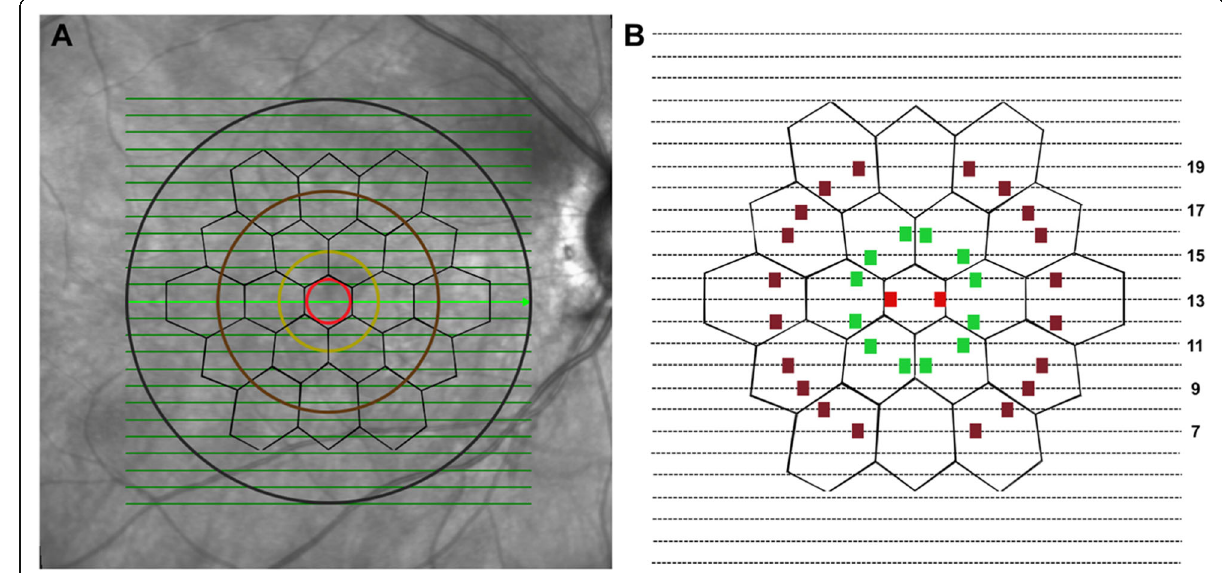
Fig. 2 The correlation of spectral-domain optical coherence tomography (SD-OCT), multifocal electroretinography (mfERG) hexagons, and the microperimetry (MP). a The SD-OCT line scans intersect various hexagons of the mfERG as shown. Concentric circles with diameters of 2.3°, 6.6°, and 11.1° (representing the topographic locations of the MP test points) are also shown in red, green, and brown circles. Analysis of the retinal layers was performed at the locations where the superimposed circles intersected the line scans of the SD-OCT. Two points were selected, and their values were averaged within 17 hexagons (hexagon numbers 11 and 17 were excluded since the line scans did not intersect the circles representing the MP test points) so that a total of 34 areas were analyzed for each SD-OCT scan ( b